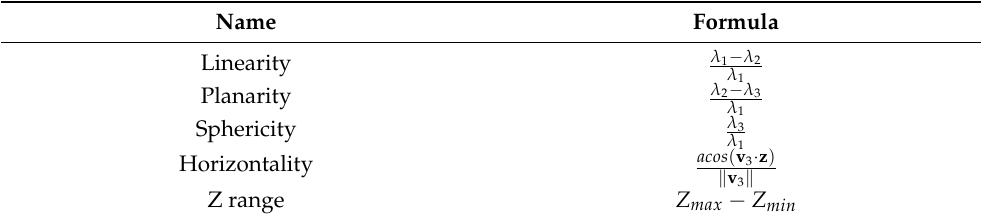
Table 3. Features extracted from the point